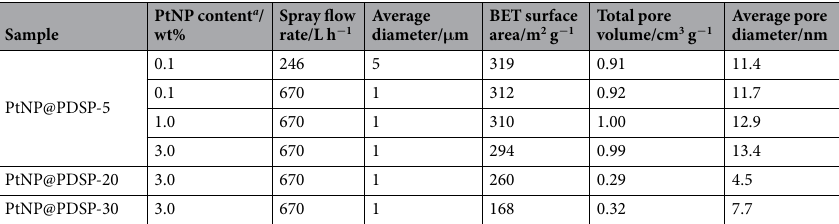
Table 1. Pore properties of PtNP@PDSPs fabricated under various conditions. a Pt content with respect to ND in the ND/PtNP/PEG